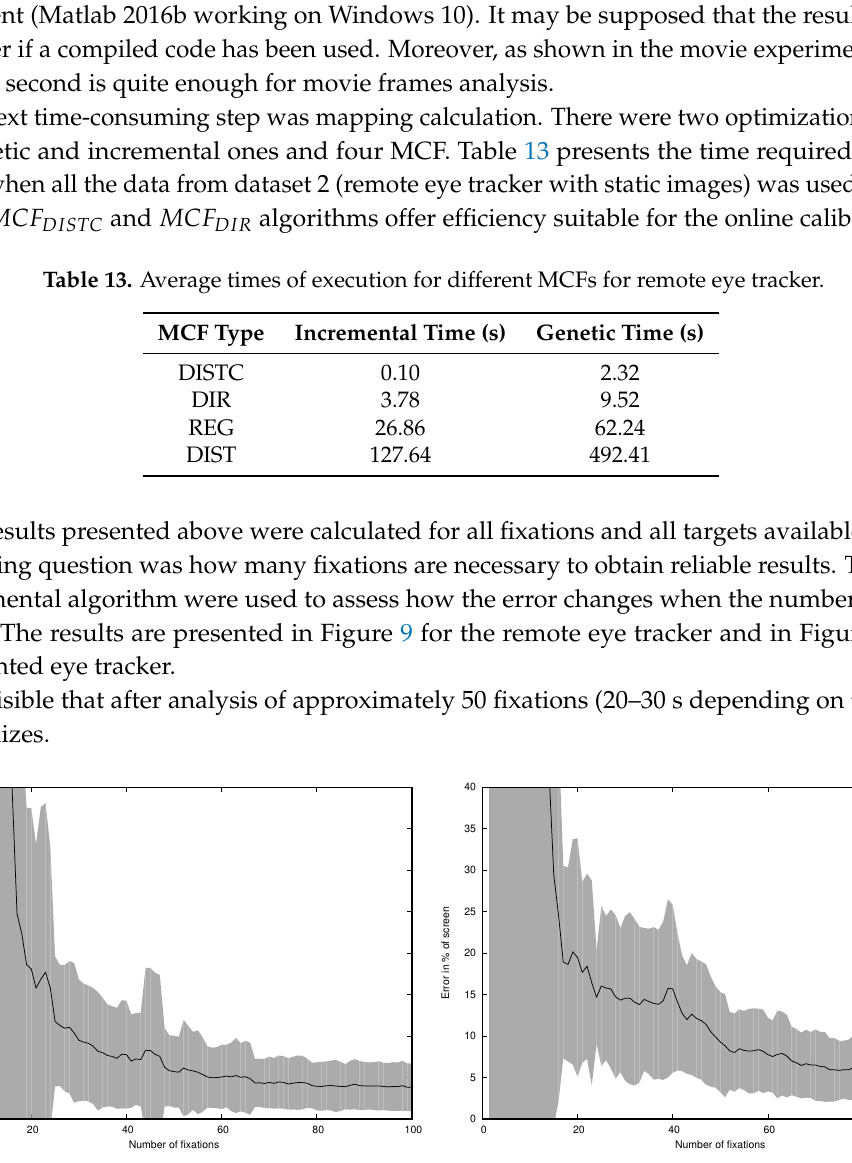
Figure 9. Error for the remote eye tracker with MCF DIR and incremental algorithm depending on the number of fixations. Left: horizontal error, right: vertical error. The gray area represents standard